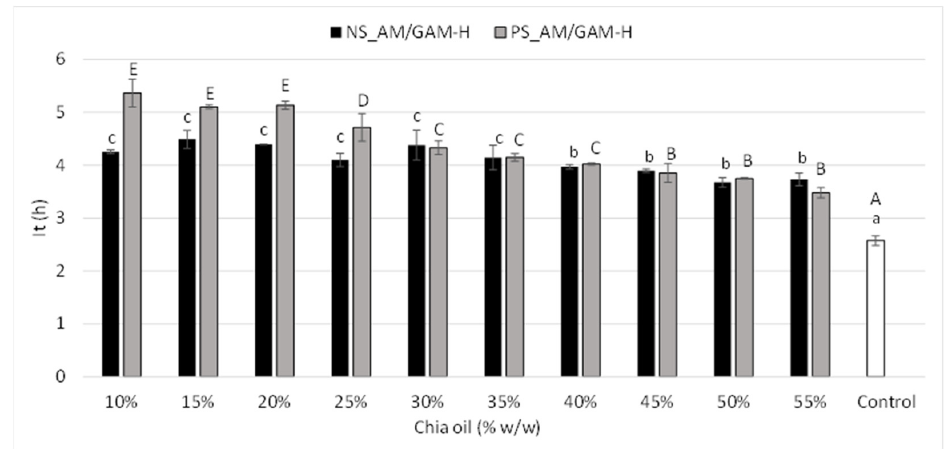
Figure 5. Induction time of impregnated chia oil in native starch (NS) and pretreated starch (PS) hydrolyzed with the mixture of α -amylase and glucoamylase with the highest dose (AM/GAM-H). Data shown as mean ± SD, n = 3. Lowercase letters represent the statistical analysis of the total sam- ples; capital letters represent the statistical analysis of each starch sample separately. Means in the same column color followed by the same letter are not significantly different ( p < 0.05).